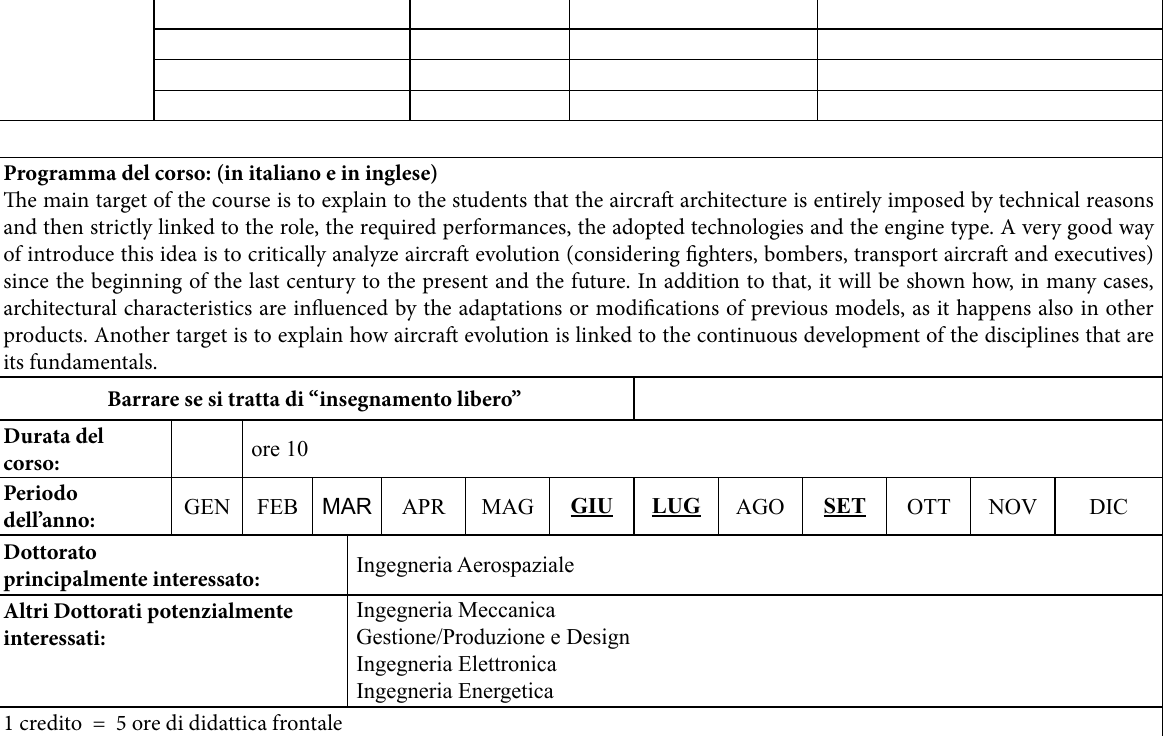
Fig. 1. The form for the proposal of a III level